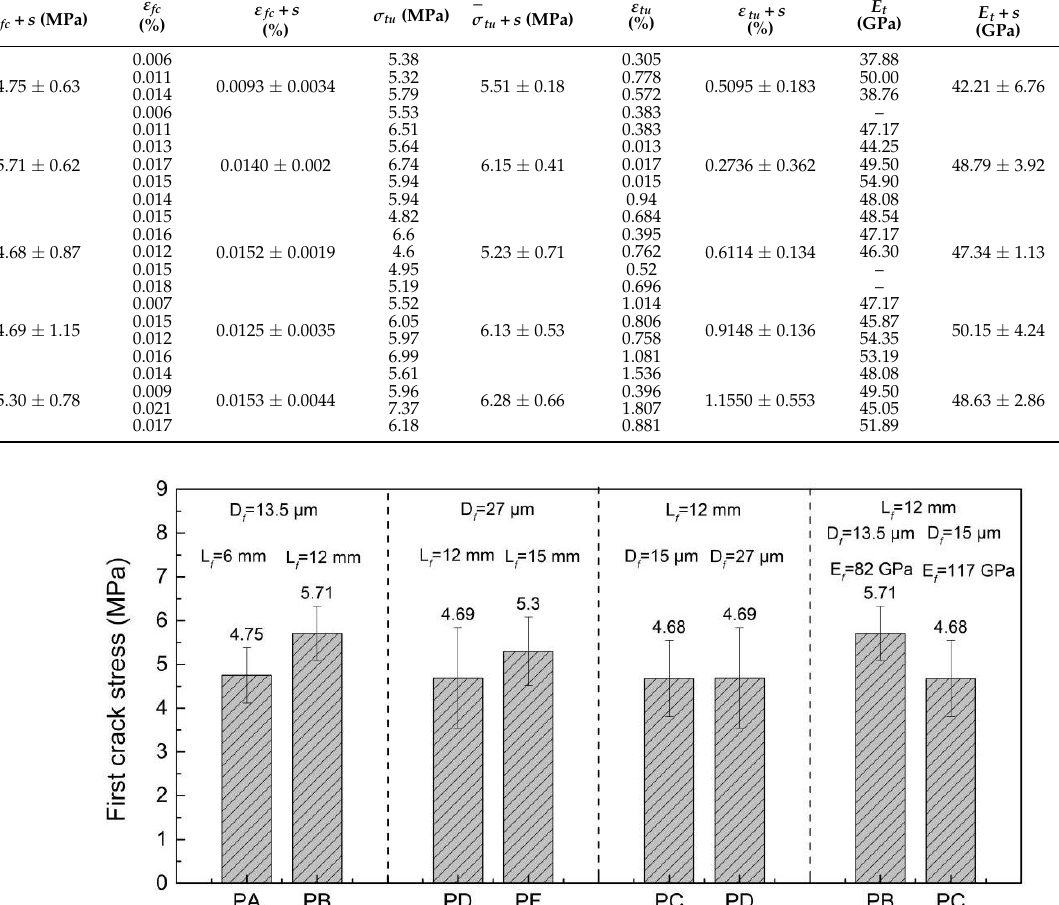
Table 5. Uniaxial tensile parameters of UHPC with PE fiber.